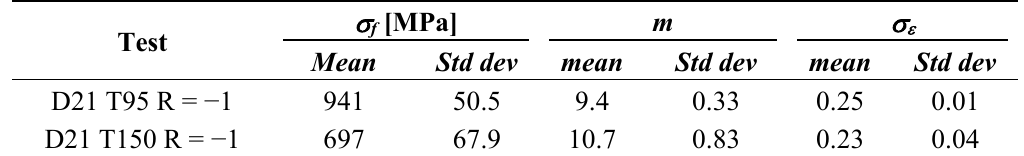
Table 3. Estimated statistical parameters from tests with log-normal model for fatigue